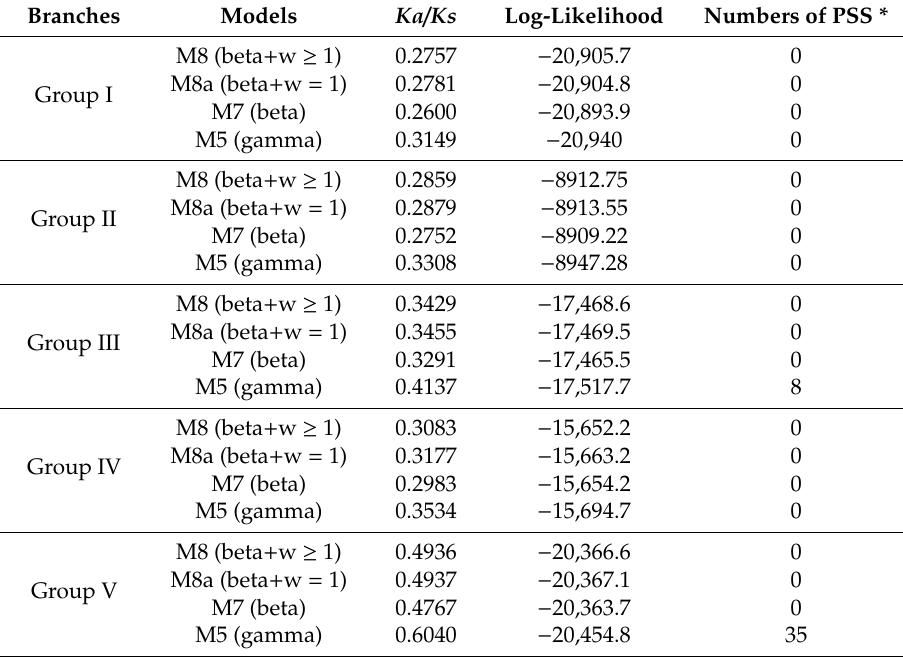
Table 3. Likelihood values and parameter estimates regarding selection upon CYP